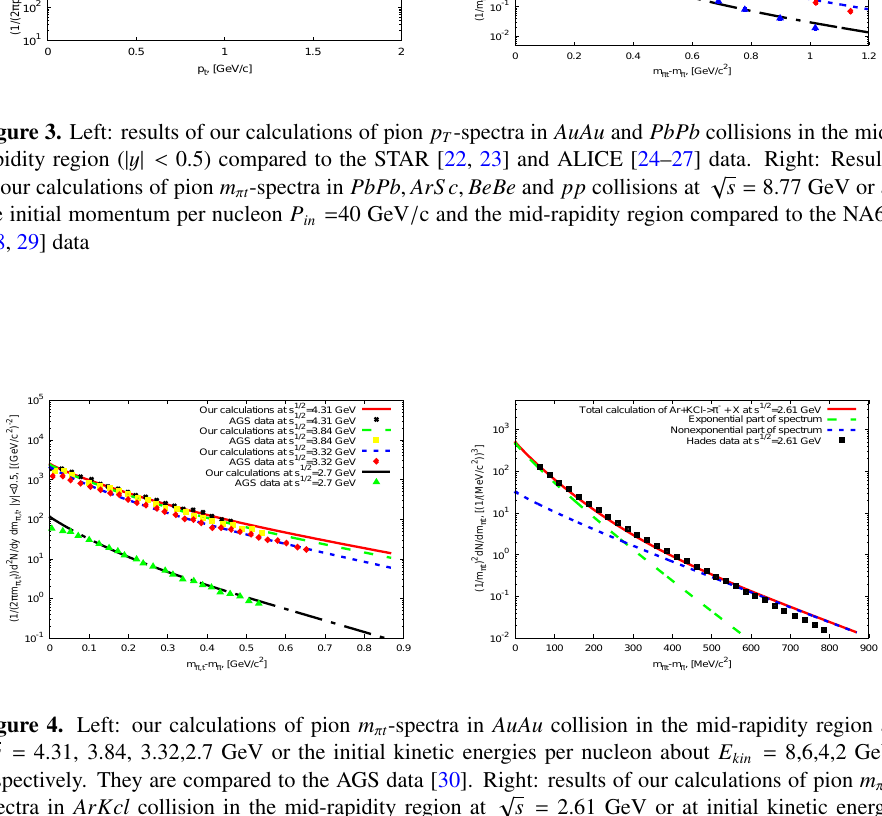
√ s = 8.77 GeV or at